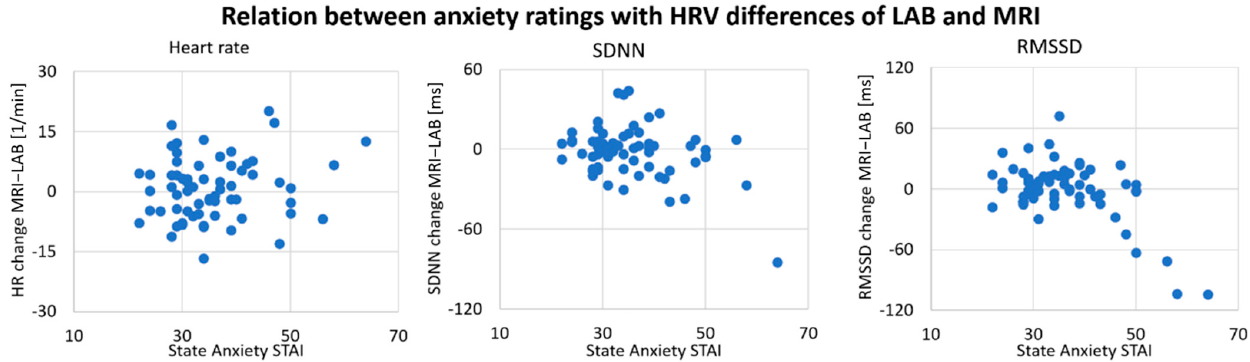
Figure 4. Relationship between anxiety ratings (STAI state anxiety) and HRV differences between LAB (based on ECG) and MRI (based on PPG) over all participants (N = 79). HR: mean heart rate; SDNN: standard deviation of heart beat intervals; RMSSD: root mean square of successive heart beat intervals; MRI: HRV derived from a photoplethysmogram recorded during MRI; LAB: HRV derived from an electrocardiogram recorded in the laboratory.